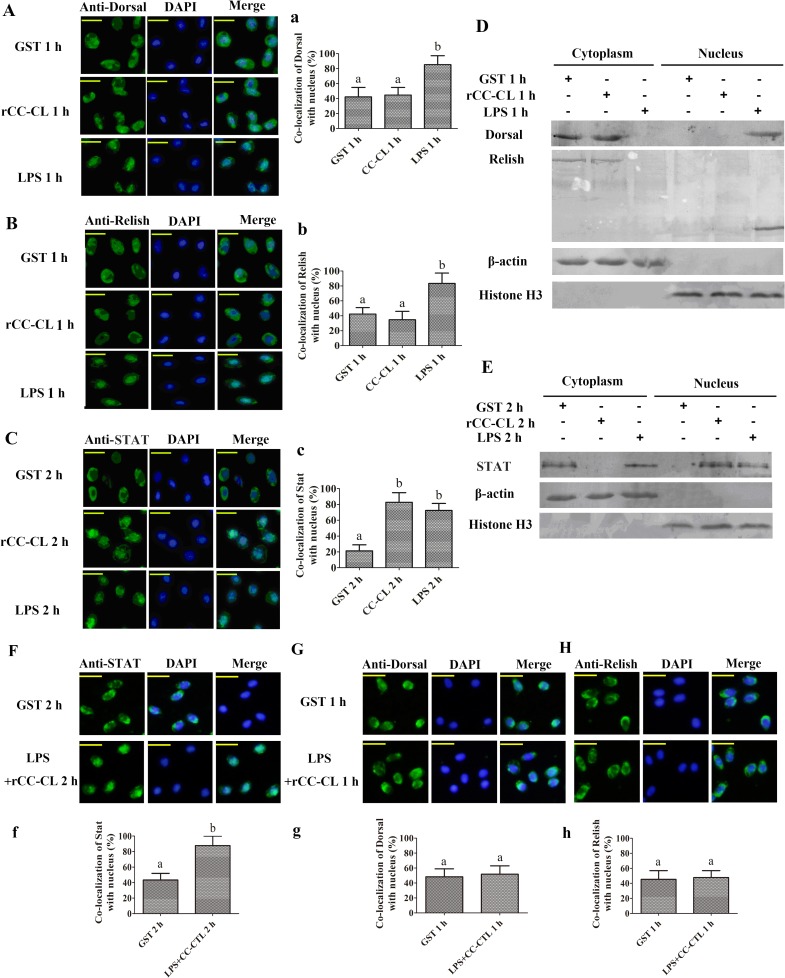
MjCC-CL induces STAT (but not Dorsal or Relish) translocation into nucleus.(A). Dorsal translocation into the nucleus in hemocytes was detected in rMjCC-CL-injection shrimp. GST and LPS were separately used as negative and positive control. (a) Statistic analysis of co-localization of Dorsal with nucleus with WCIF ImageJ software. (B) Relish translocation into the nucleus in hemocytes was detected in rMjCC-CL-injection shrimp. GST and LPS were separately used as negative and positive control. (b) Statistical analysis of co-localization of Relish with nucleus. (C) STAT translocation into the nucleus in hemocytes was detected in rMjCC-CL-injection shrimp. (c) Statistical analysis of C. (D) The subcellular distribution of Dorsal and Relish in intestine was detected by western blotting after rMjCC-CL-injection. (E) The subcellular distribution of STAT in intestine was detected by western blotting after rMjCC-CL-injection. β-actin and histone H3 were used as loading controls for the cytoplasmic or nuclear proteins. GST and LPS were separately used as negative and positive control. (F-H) Recombinant MjCC-CL bound with LPS was injected into shrimp, STAT (F) Dorsal (G), and Relish (H) translocation into the nucleus in hemocytes were detected by immunocytochemical assay. GST was used as negative control. (f-h) Statistic analyses of co-localization of STAT, Dorsal and Relish with nucleus using WCIF ImageJ software. Different letters indicate significant differences (p < 0.05) in one-way ANOVA analysis.